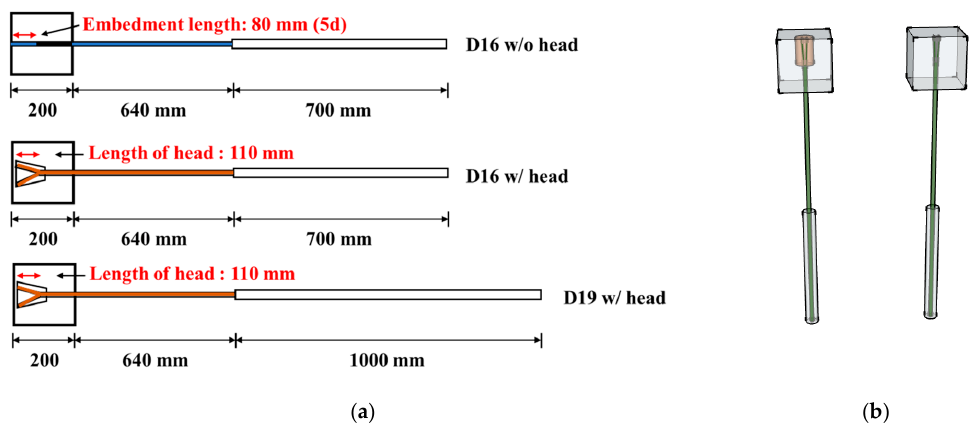
Figure 7. Details of specimens for the pull-out test: ( a ) specimen profiles and ( b ) a schematic view of the longitudinal cut head (LC) and concrete head (CH) specimens.